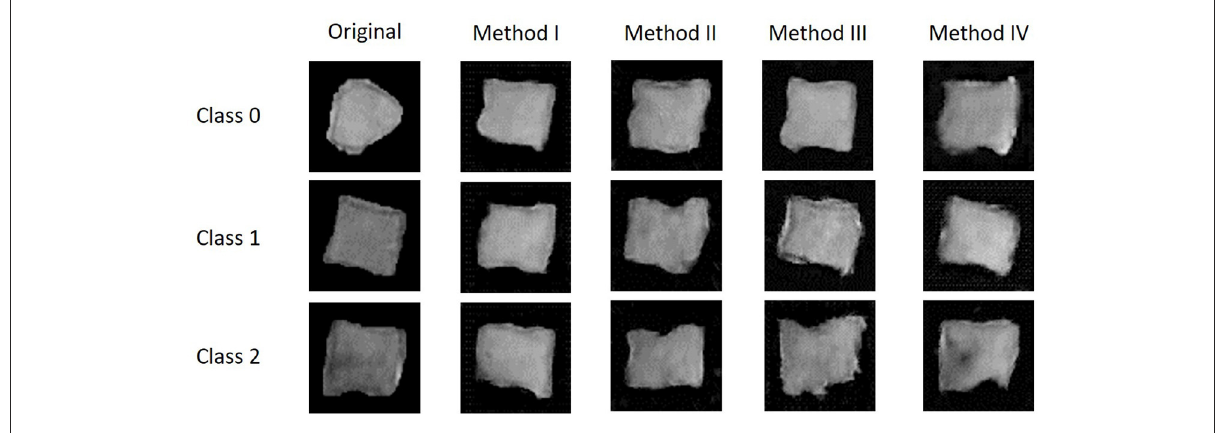
FIGURE6 Generated results of the individual methods. Class 0 = healthy; class 1 = abnormal but not pathological; class 2 = pathological.